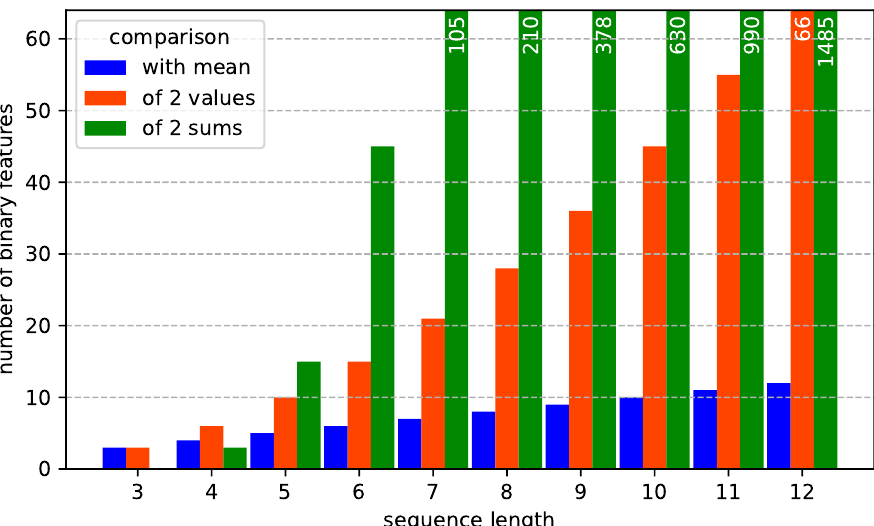
Figure 4. Number of binary features (BF) by type. Blue: BF created by comparing single brightness values with the mean brightness of the pixel. Orange: BF created by comparing 2 brightness values of the sequence with each other. Green: BF created by comparing two sums with each other, which have each been calculated from two brightness values (only for